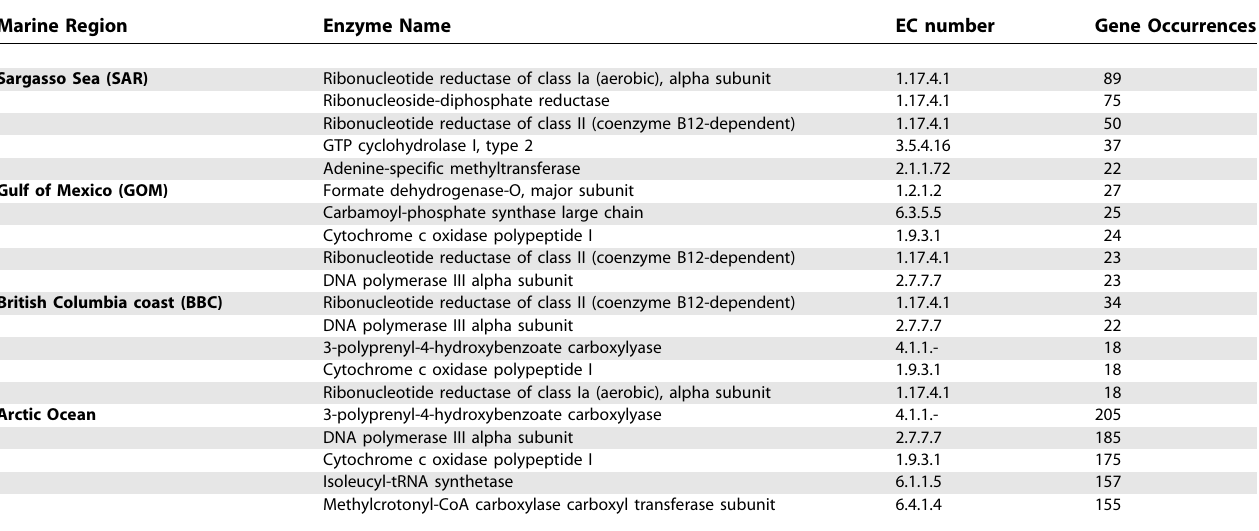
Table 2. The Most Abundant Enzyme-Coding Genes in the Four Oceanic Viral Metagenomes Marine Region Enzyme Name EC number Gene Occurrences Sargasso Sea